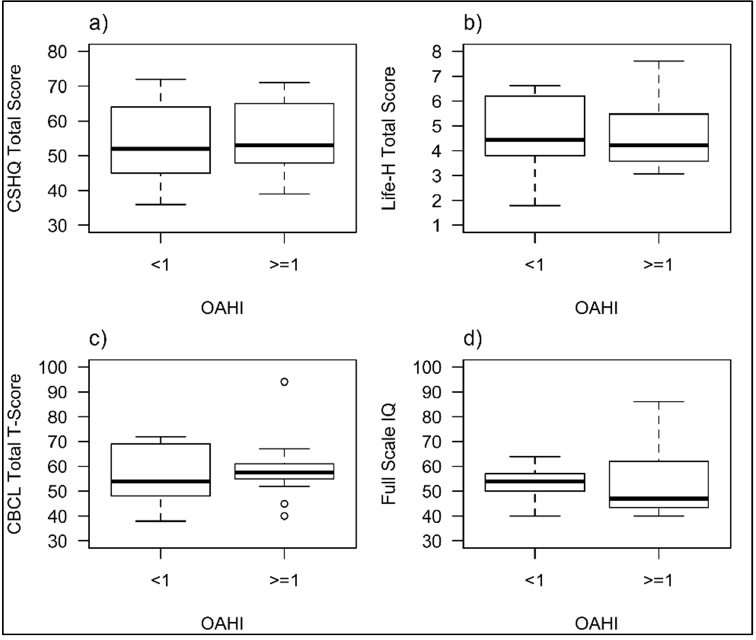
Figure 3. Comparison of CSHQ scores ( a ), functional ability ( b ) general behaviour ( c ) and IQ ( d ) between children with and without OSA on PSG.